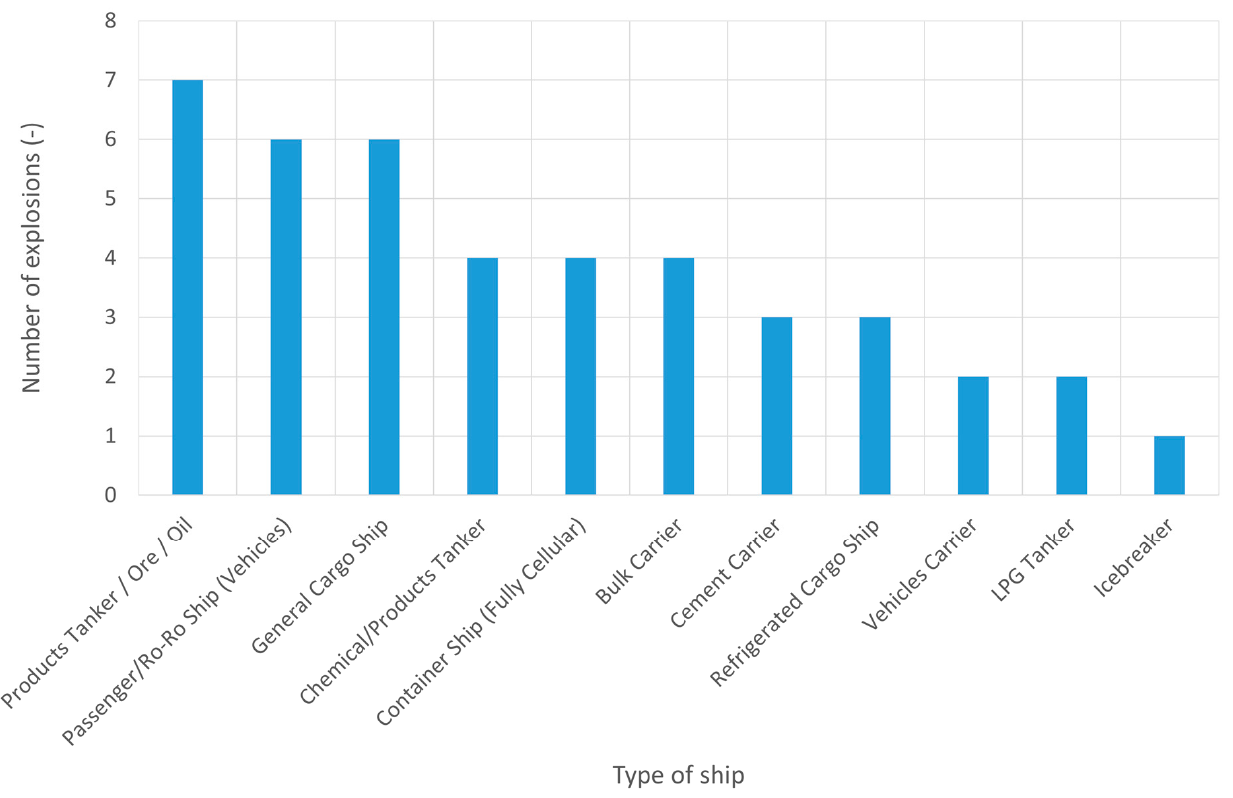
Figure 11. Number of main engine turbocharger explosions as a function of the ship’s type.